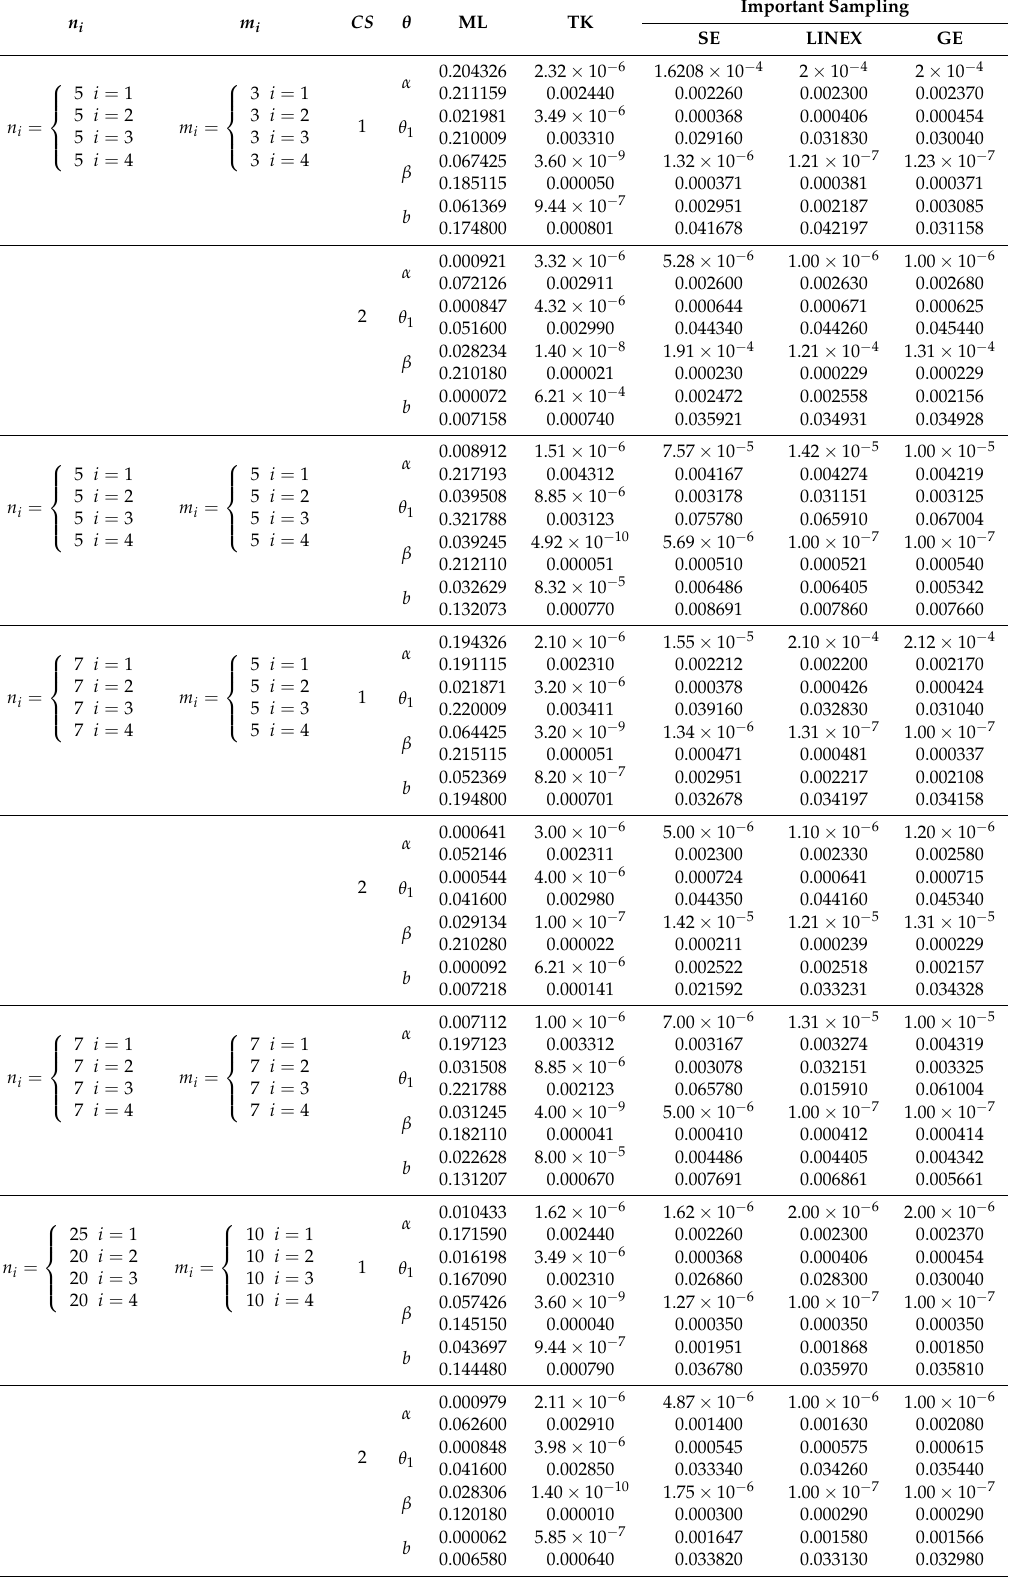
Table 5. Mean square errors (MSEs) and RABs for MLEs and BEs of α , θ 1 , γ , and b with true values ( γ = 1.4, α = 0.5, θ 1 = 0.7 and b = 1.2), values of hyper-parameters ( µ 1 = 196000, µ 2 = 2500, µ 3 =